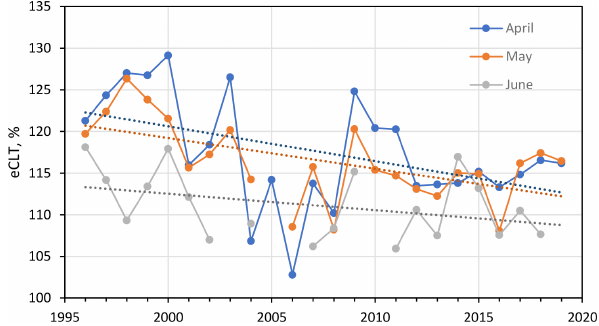
Figure 15. Monthly mean clear-sky eCLT in Ny-Ålesund for April, May, and June 1996 to 2019. Trends in clear-sky eCLT are indicated as dotted